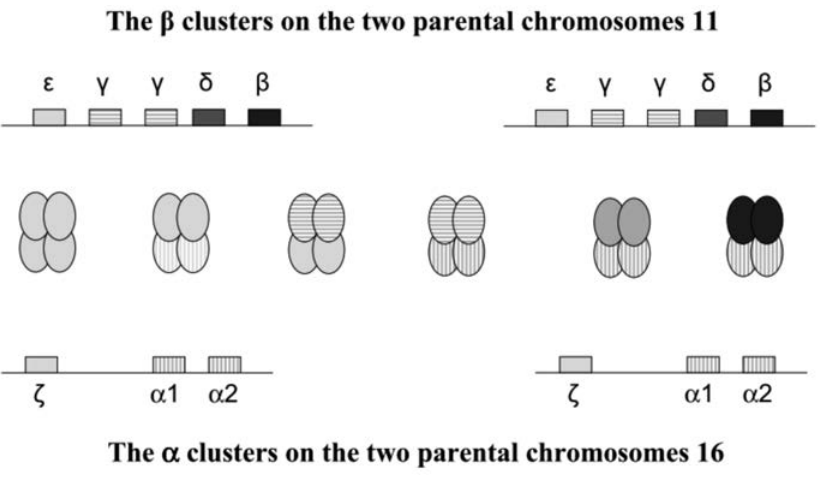
Figure 1. Globin genes coding for embryonic, fetal and postnatal hemoglobin (Hb) tetramers. From left to right: Hb Gower1, Hb Gower2, Hb Portland, HbF, HbA HbA.